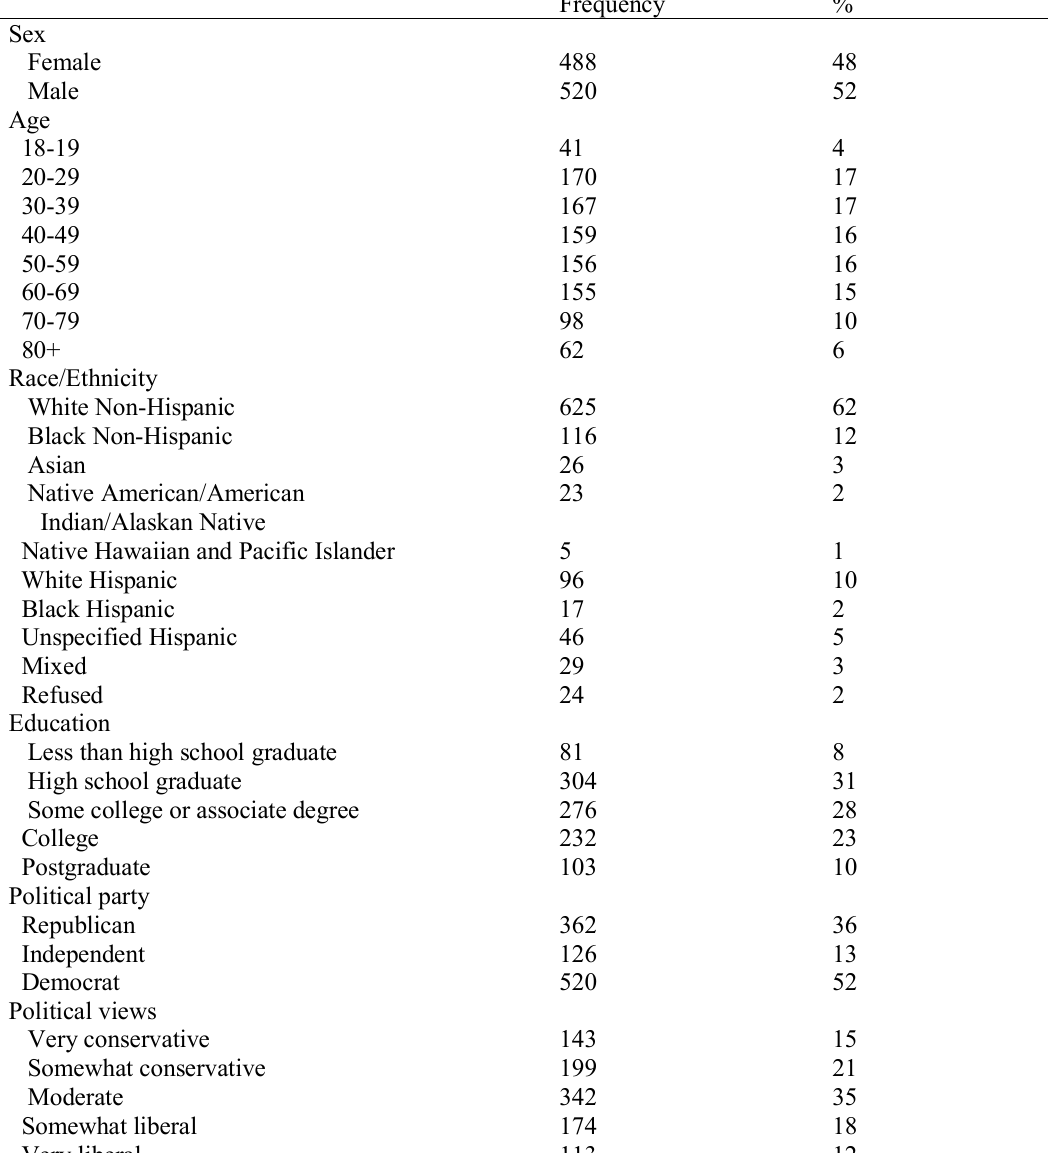
Table 3. Description of the